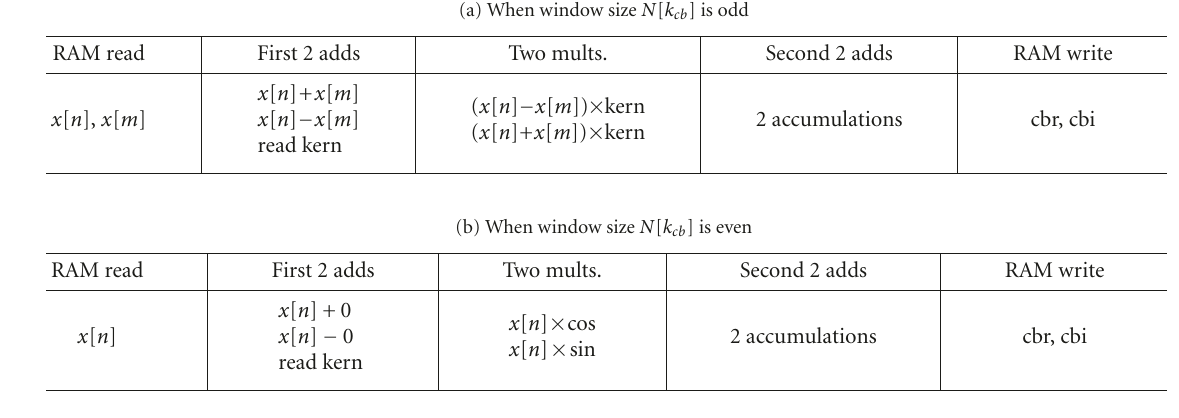
Table 3: Last butterfly operation in the pipeline.